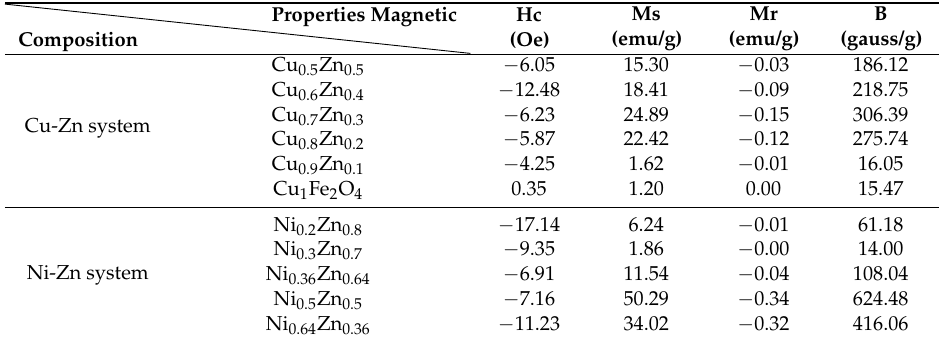
Table 1. The hysteresis curve for [M x Zn 1 − x ] Fe 2 O 4 at different compositions and proportions; Hc: